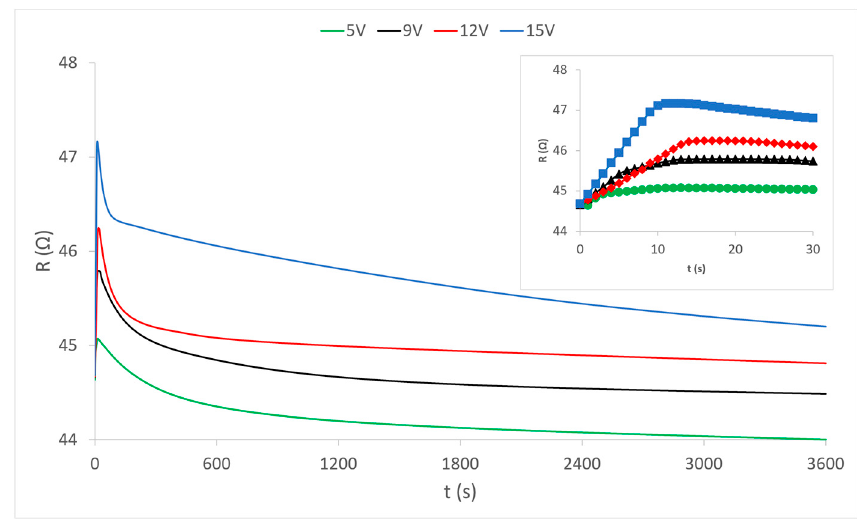
Figure 6. Change in the electrical resistance of the electrically conductive yarn of sample 3 under the influence of heat by heating at given voltage values.